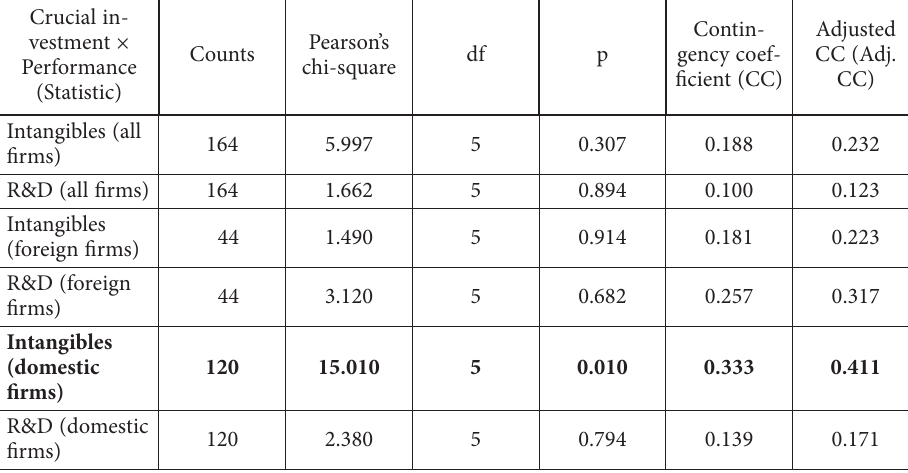
Table 10. Contingency: crucial investment × performance – statistics (source: own) Crucial in- vestment ×